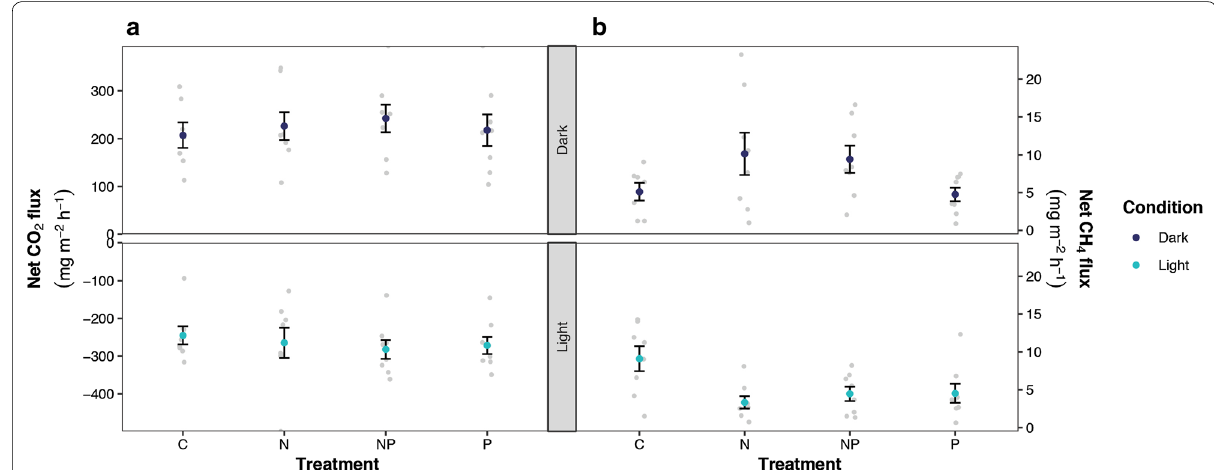
Fig. 1 Plot showing the average a net CO 2 flux (mg C m − 2 h − 1 ) and b net CH 4 flux (mg C m − 2 h − 1 ) measured in light (light blue, lower panels) and dark (dark blue, upper panels) conditions depicted for each fertilization treatment. Error bars indicate SEM and light grey dots show raw data. Negative values indicate net fluxes from atmosphere to peat